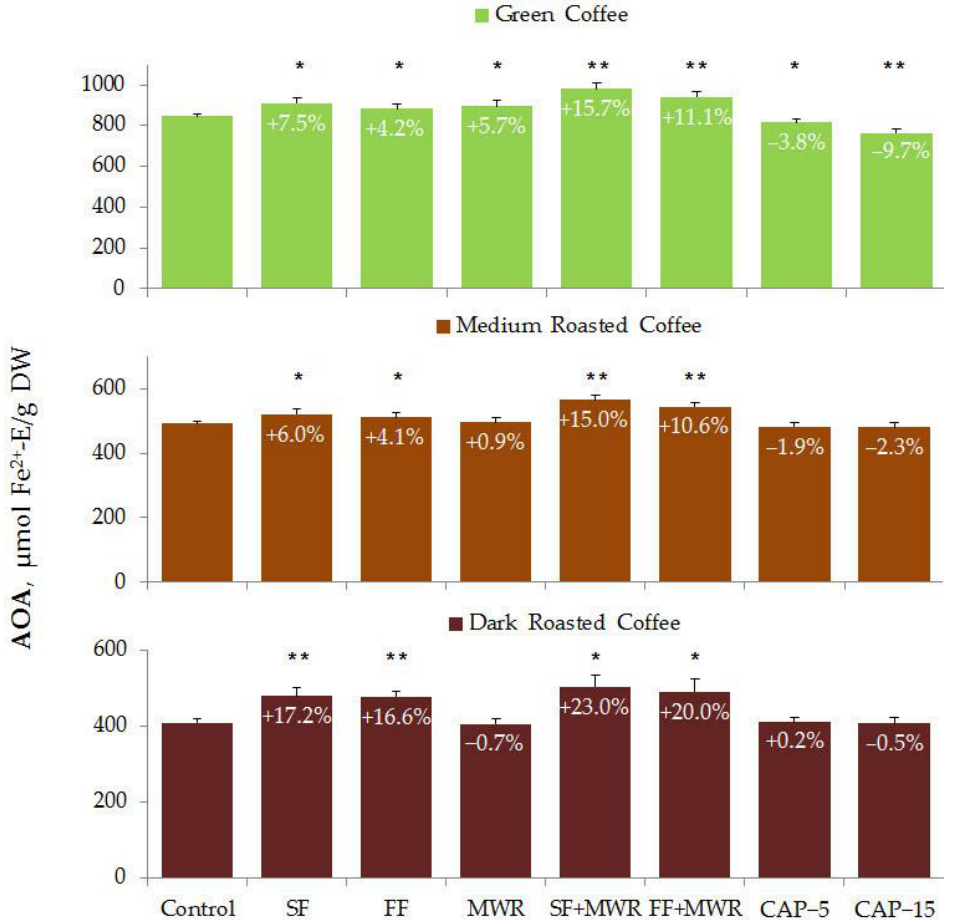
Figure 3. The AOA of aqueous extracts of untreated (control) and treated coffee beans ( n = 3). Percentage indicates the change in the average value of AOA after treatment. Bars indicate the upper boundaries of the SD. Statistically significant differences relative to the control are indicated by one ( p < 0.05) and two ( p < 0.01) asterisks.